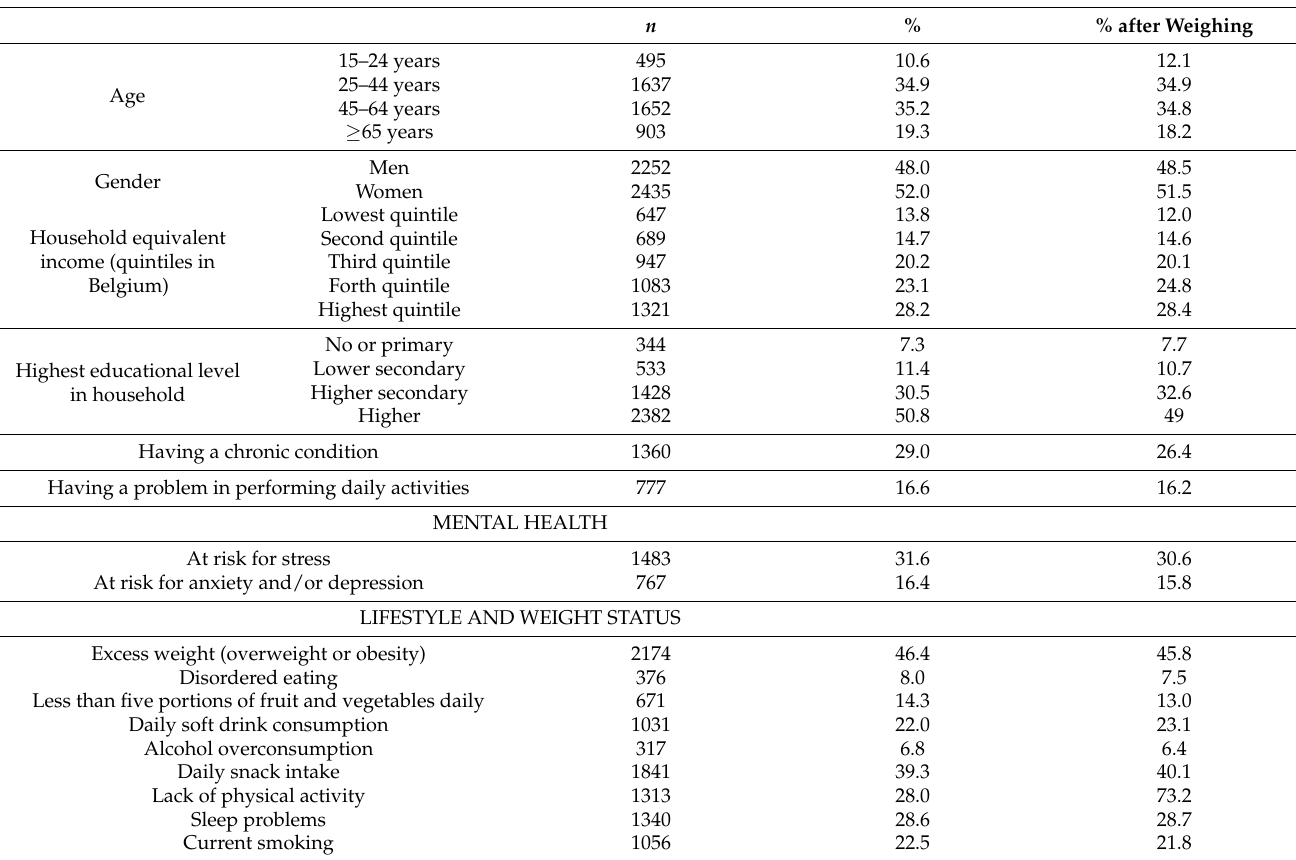
Table 1. Descriptive data on the study population ( n =